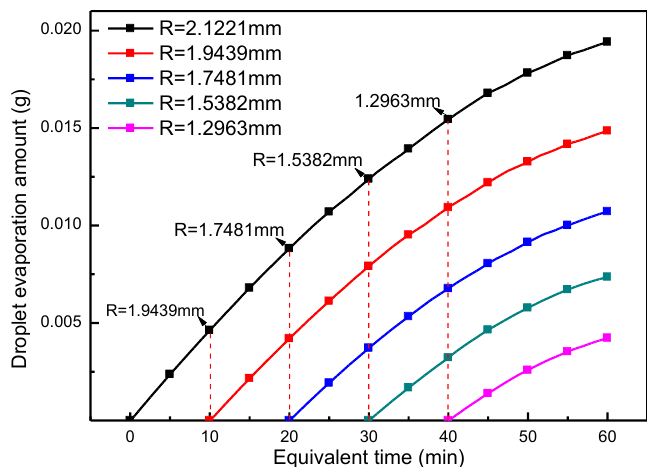
Figure 12. Evaporation at each moment for different initial droplet radii.